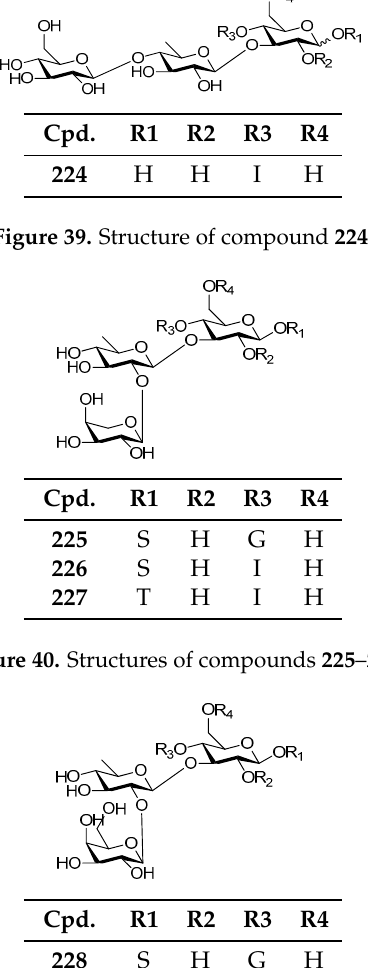
Figure 38. Structures of compounds 221 – 223 .